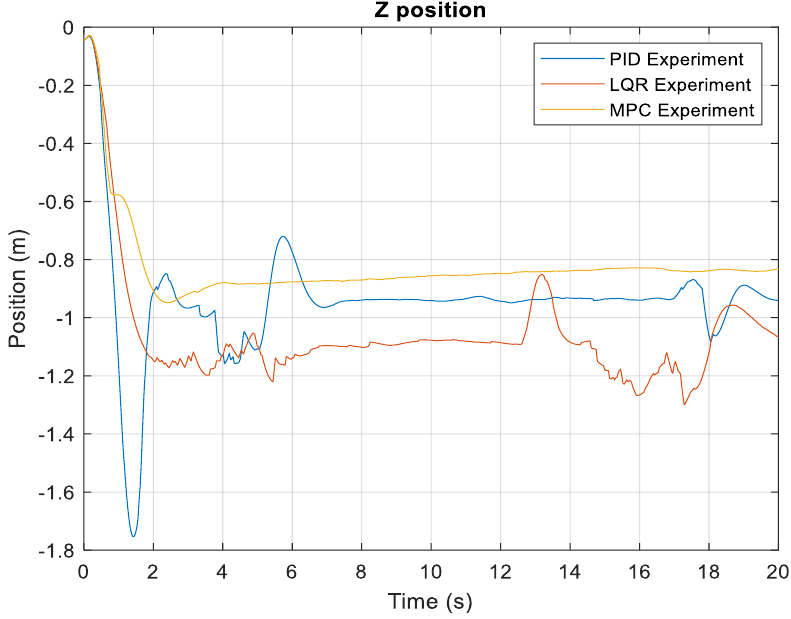
Figure 9. Performance of the controllers along z axis in real-time.